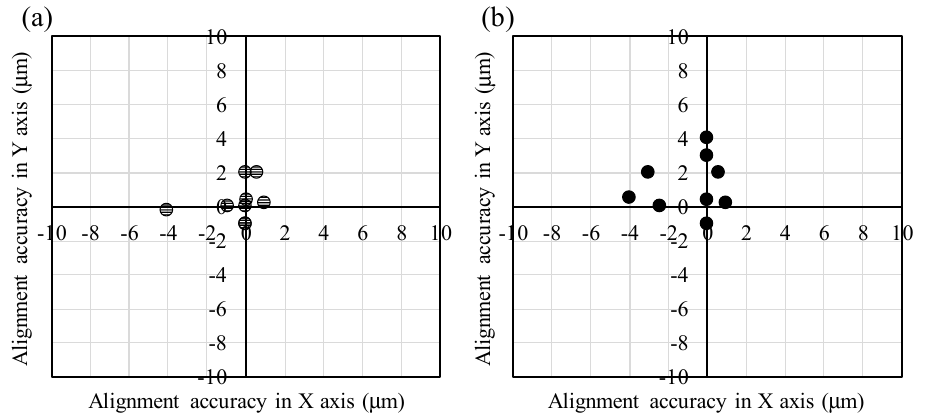
Figure 8. A photomicrograph of self-assembled chips directly bonded to a wafer through CMP- treated PE-CVD oxide. 2.4. Impact of Plasma Activation on Oxide-Oxide Direct Bonding The effects of N 2 plasma irradiation and water dipping on MCtW direct bonding are characterized in this session. Therefore, most papers have discussed oxide-oxide bonding with thermally oxidized Si wafers and/or bare Si wafers in detail [30,31,44,45]. A few papers have described the detailed mechanism of direct bonding through CVD oxide [34,38]. Gösele et al. have reported that the chemistry of the Si–Si bonding process with wafers is basically the same as in the case of fused silica, since bare Si wafers are normally covered with at least a few angstroms of native oxide [30]. In the Gösele model, Van der Waals forces based on hydrogen bond networks between oxygen and hydrogen atoms dominates SiO 2 –SiO 2 direct bonding through absorbed water layers in which water molecules form a water cluster at the temperature of below 100 °C. As the temperature goes up at above 100 °C, the water can diffuse around the bonding interface, resulting in hydrogen bonds between silanol groups on the surface of upper and lower wafers. Then, covalent bonds of siloxane linkages are formed at the SiO 2 –SiO 2 bonding interface at temperatures ranging from 200 °C to 700 °C. It is not until the temperature is increased beyond 700 °C that the SiO 2 – SiO 2 interface permits closure of nano-gaps between the Si wafers. This mechanism of SiO 2 viscous flow at high temperature by annealing is illustrated in Figure 9a.